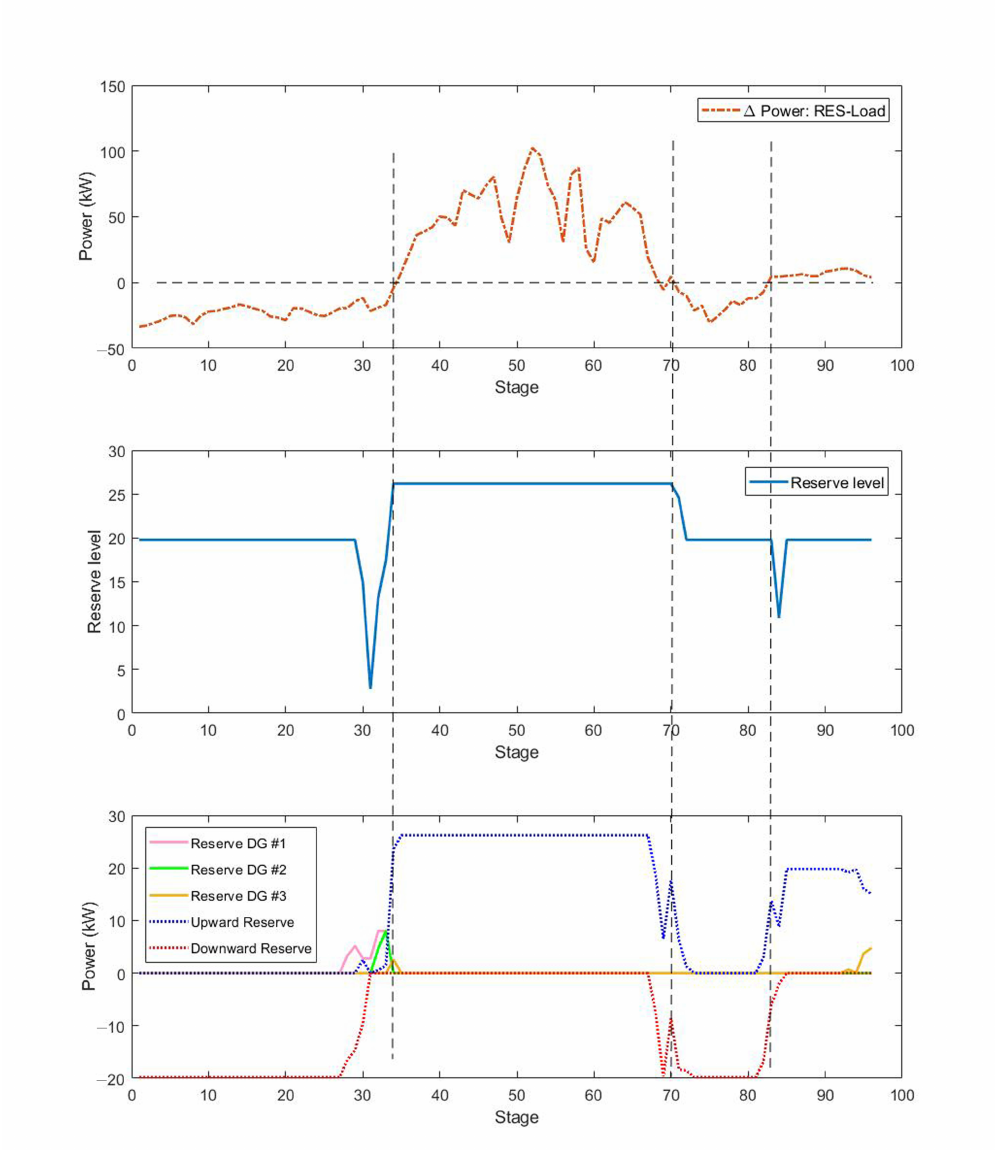
Figure 8. Simulation results related to the reserve strategy. ( Top ) the power differences of RES generation and load demand. ( Middle ) the total reserve level over stages. ( Bottom ) the reserve power in battery and DGs.